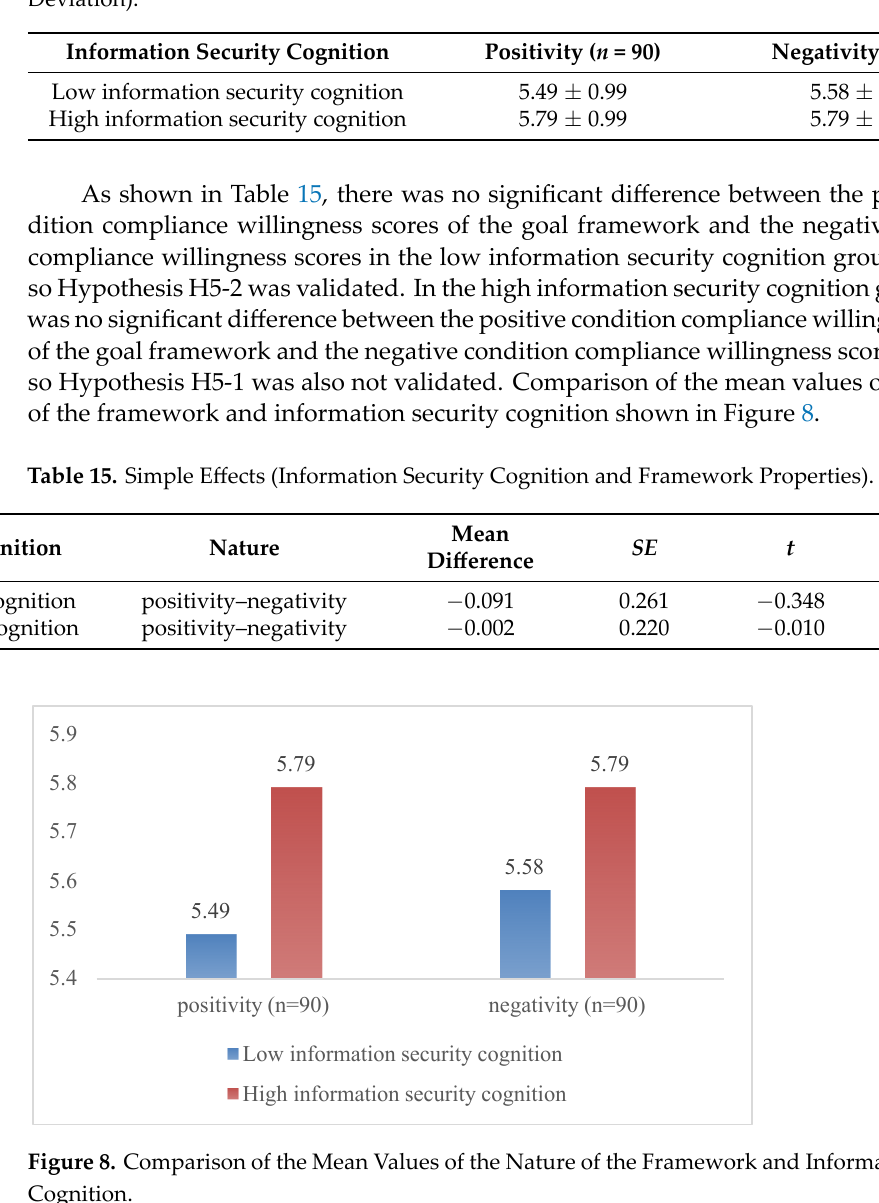
Table 16. Reliability and Validity Analysis Results.